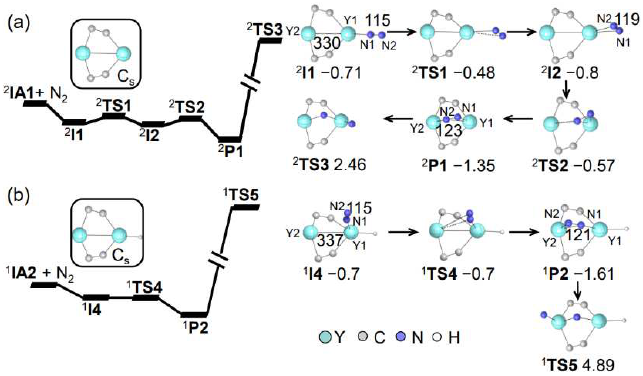
Figure 2. BPW91-D3-calculated potential energy surfaces for the reactions of Y 2 C 4− ( a ) and Y 2 C 4 H − ( b ) with N 2 . The zero-point vibration-corrected energies (Δ H 0K in eV) of the reaction intermediates ( I1 – I4 ), transition states ( TS1 – TS4 ), and products ( P1 , P2 ), with respect to the separated reactants, are given. The bond lengths are given in pm. The green, blue, grey and white atoms represent Y, N, C and H atoms, respectively. Spin multiplicity is located in superscript.